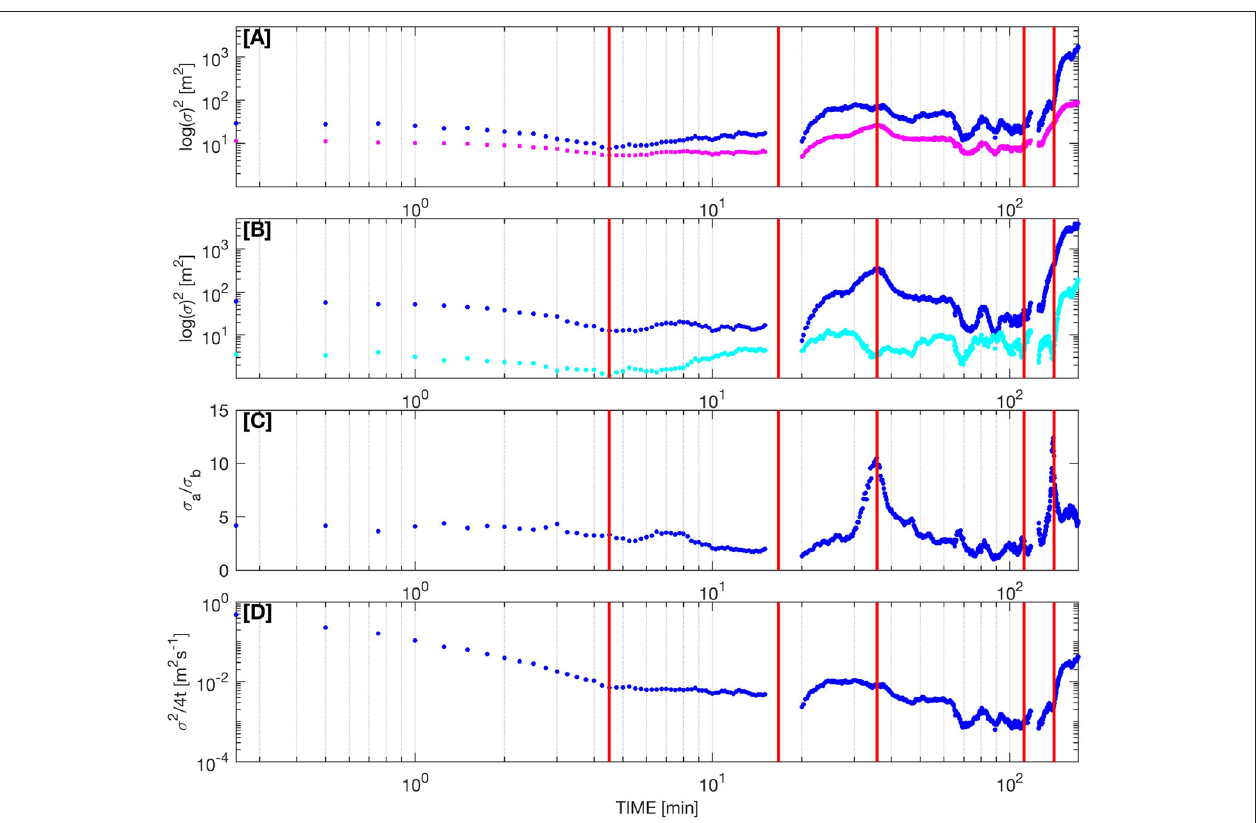
FIGURE 12 | (A) Cloud dispersion, σ 2 = 2 σ a σ b of the patch of plates (blue dots) and average relative dispersion of pairs of plates (pink dots) plotted as a function of time on a logarithmic scale. (B) The major and minor axes of the dispersion ellipses are denoted by dark blue and cyan colors, respectively. (C) The dispersion ratio σ a /σ b . (D) The diffusivity ( σ 2 4 t ) computed from Equation 11. Vertical red lines correspond to snapshots in Figure 11 and times mentioned in the